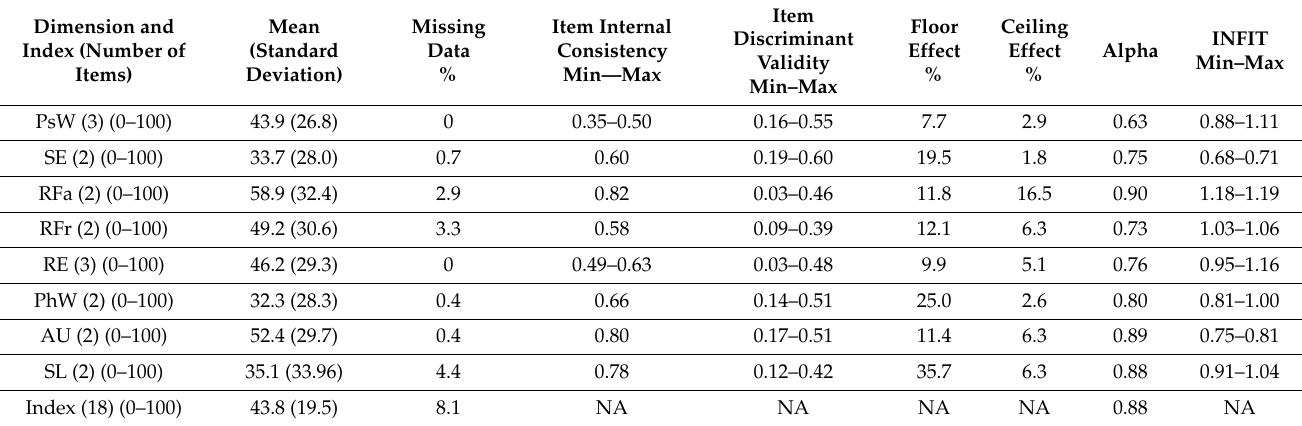
Table 2. Dimension characteristics of the S-QoL 18 ( n =